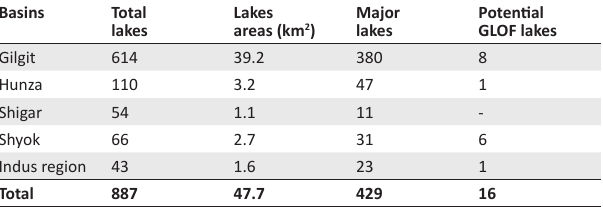
TABLE 1: Overview of the glacial lakes in the major river basins of the Karakoram Range, Pakistan. Basins Total Lakes lakes areas (km 2